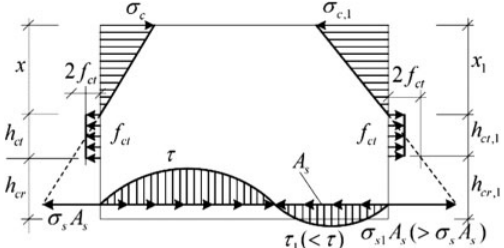
Fig. 2. Damaged equilibrium of bond forces in the zone between two adjacent cracks